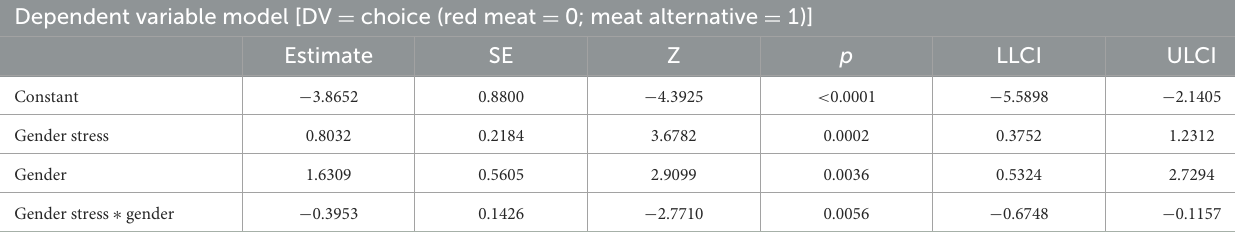
TABLE 4 Study 2 regression